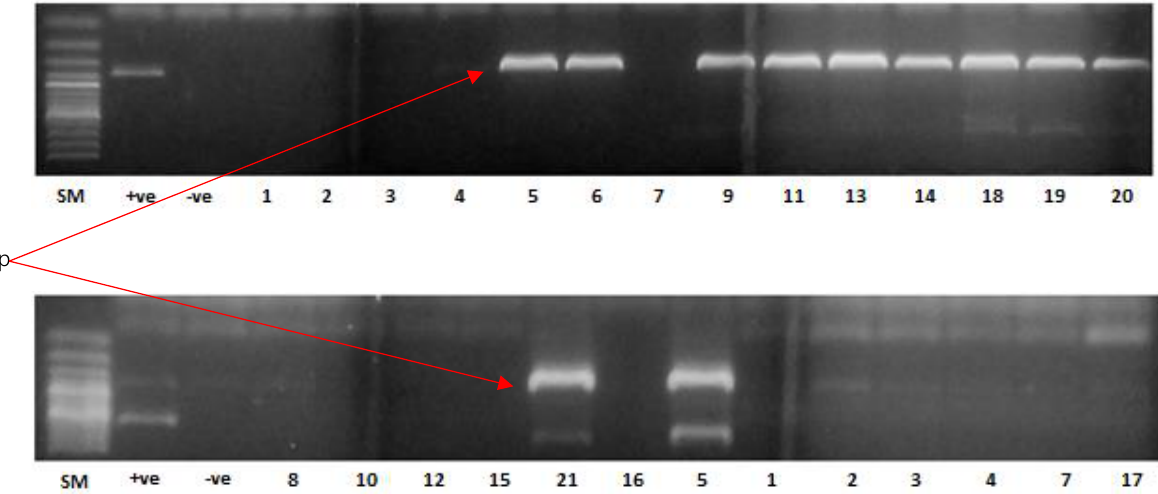
Figure 6: A representative agarose gel electrophoresis image of Polymerase Chain Reaction for the detection of Salmonella. Bands coincide with the Positive control (Salmonella Typhimurium ATCC 14028), representing the amplified product of 389 bp for the invA gene. The total occurrence of Salmonella was 0.99% (10/1010), from which 80% were isolated from different food items (Green veges 25%, Processed food 25%, Raw chicken 25%, Ready to eat food 12.5% & Spices